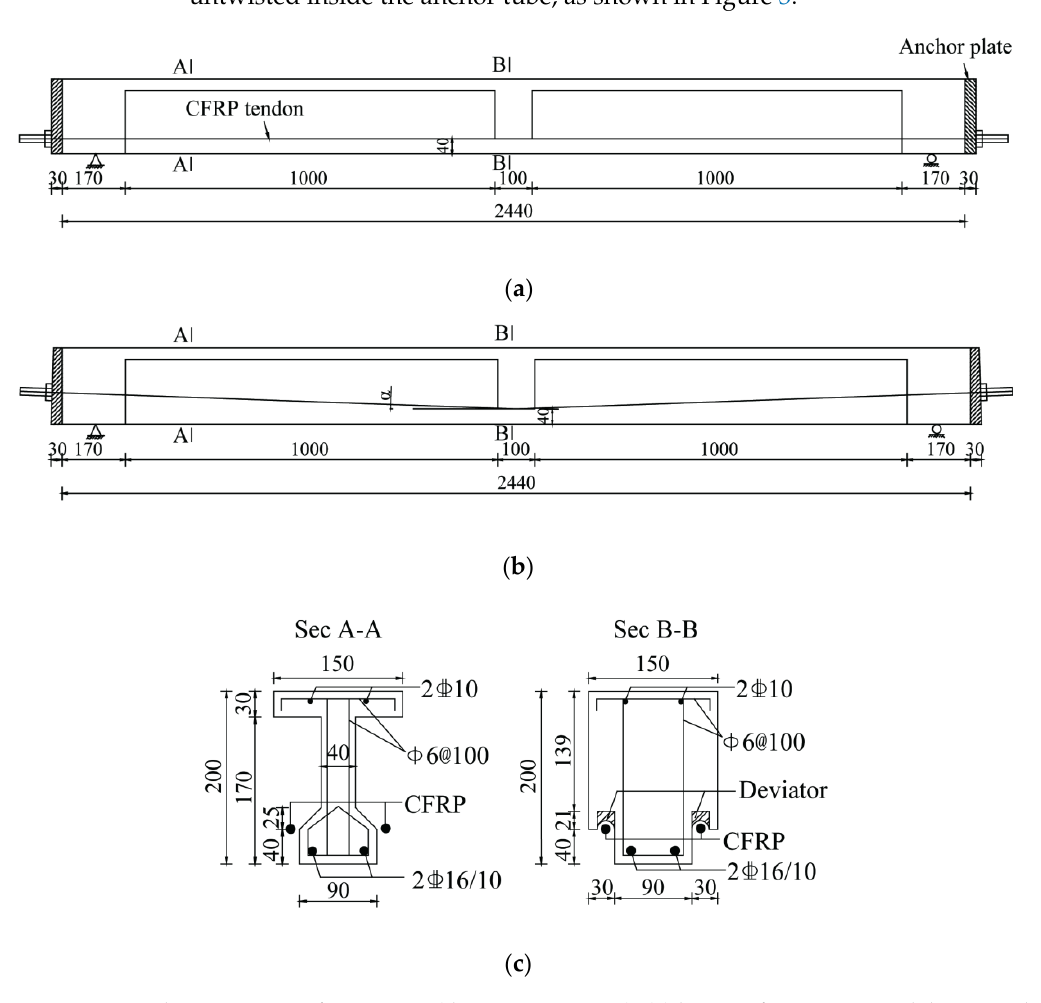
Figure 1. Dimensions and cross section of specimens (dimensions in mm): ( a ) layout of specimens with horizontal tendons; ( b ) layout of specimens with deviated tendons; ( c ) details of section A-A and B-B for partially prestressed beams.